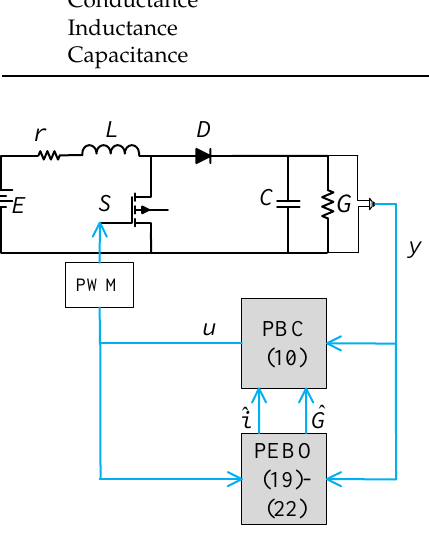
Figure 2. The control structure of boost converter under the proposed